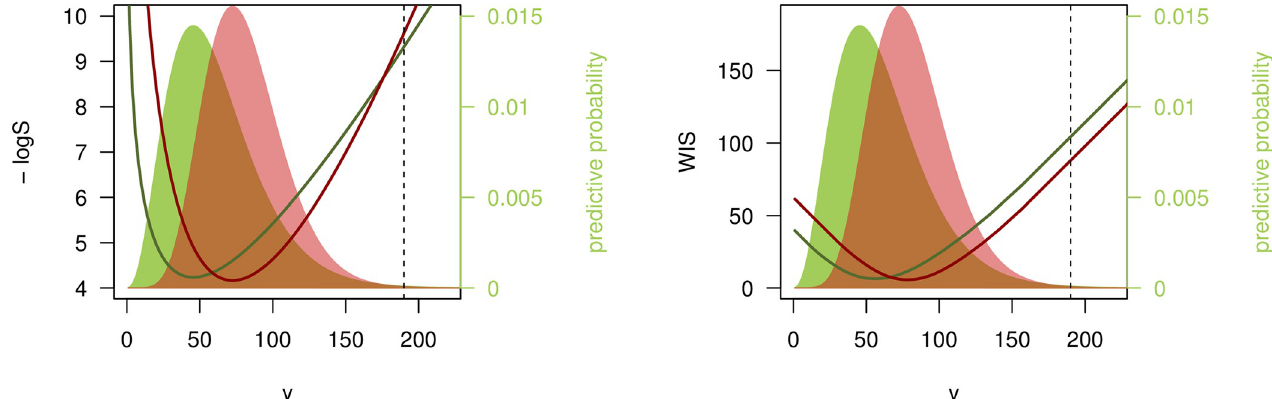
Fig 3. Disagreement between logarithmic score and WIS. Negative logarithmic score and weighted interval score (with α 1 = 0.02, α 2 = 0.05, α 3 = 0.1, ... , α 11 = 0.9 ) as a function of the observed value y . The predictive distributions F (green) and G (red) are negative binomials with expectations μ sizes ψ F = 4, ψ G = 10 . The black dashed line shows y = 190 as discussed in the text.